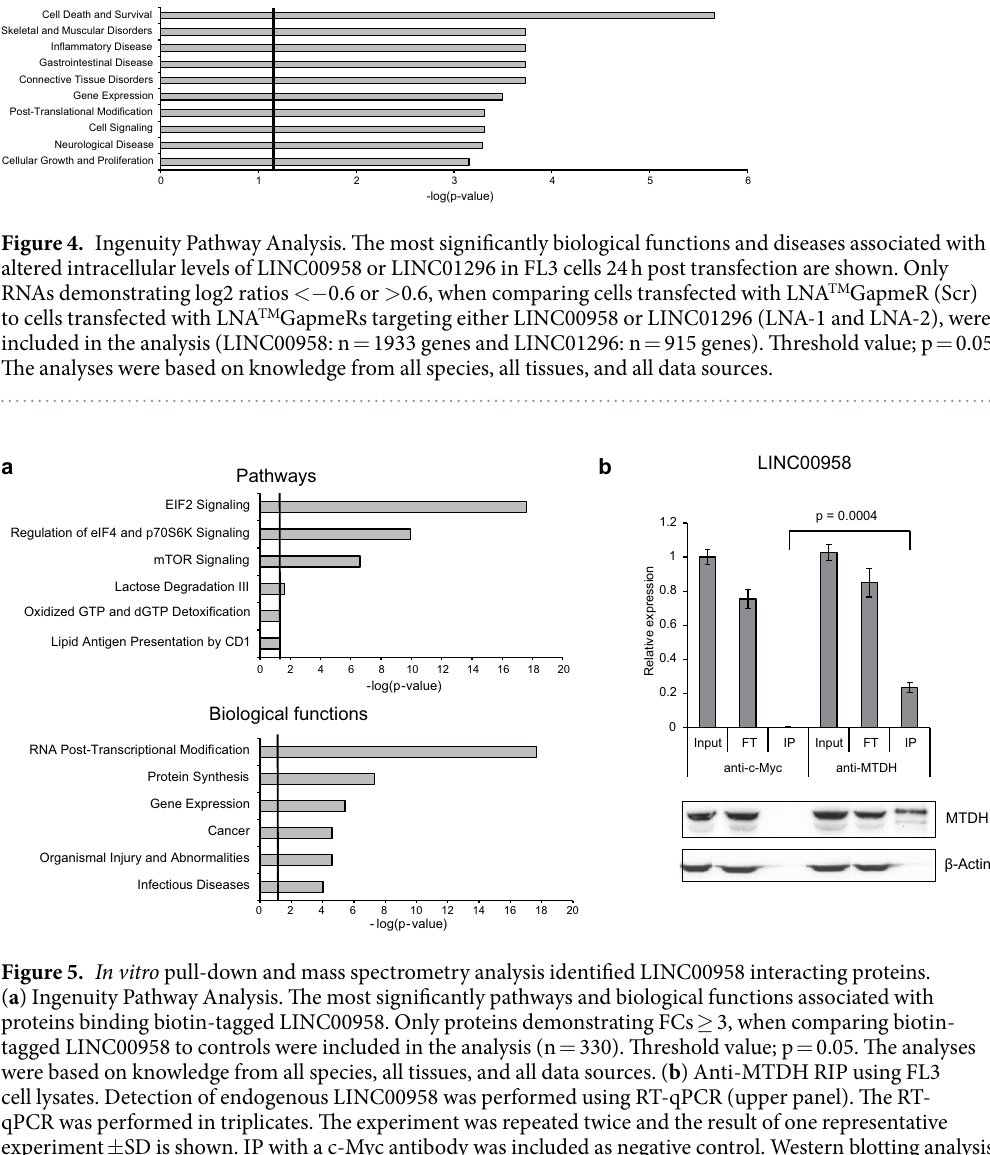
Fig. S8A). The streptavidin captured RNA (LINC00958 and controls) was incubated with FL3 cell lysates followed by mass spectrometry. Pull-down of significant amount of protein was demonstrated specifically for biotinylated RNA (Supplementary Fig. S8B). The mass spectrometric analysis yielded 330 proteins that were significantly enriched using the LINC00958 RNA as bait compared to control RNAs (FC ≥ 3) (Supplementary File S1 and Supplementary Table S6). Many of these proteins were involved in the regulation and initiation of translation and in post-transcriptional modifications of RNA (Fig. 5a and Supplementary Tables S4 and S5). Interestingly, Metadherin (MTDH) (also referred to as AEG-1 and “Protein LYRIC”), which has previously been shown to be up-regulated in BC and associated with BC progression 43, 44 , was significantly associated with LINC00958. Using